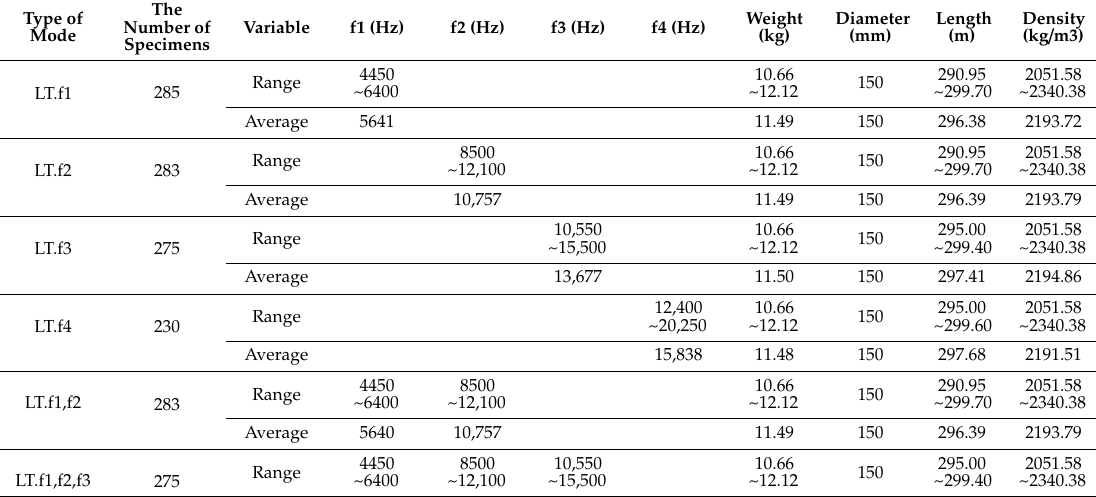
Figure 10. Relationship between the frequencies and Ei of the resonance frequency test. ( a ) LT frequencies- Ei , ( b ) TR frequencies- Ei . Table 7. Summary of used data in the LT mode for machine learning analysis.